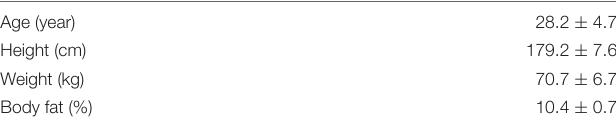
TABLE 1 | Physiological parameters of male cyclists used in this